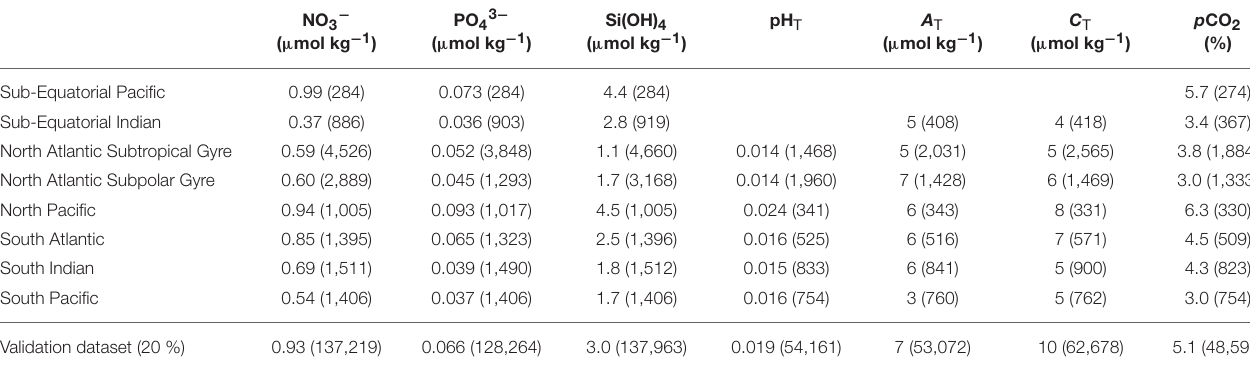
TABLE 3 | CANYON retrieval accuracy (RMSE) for each variable in each of the eight independent